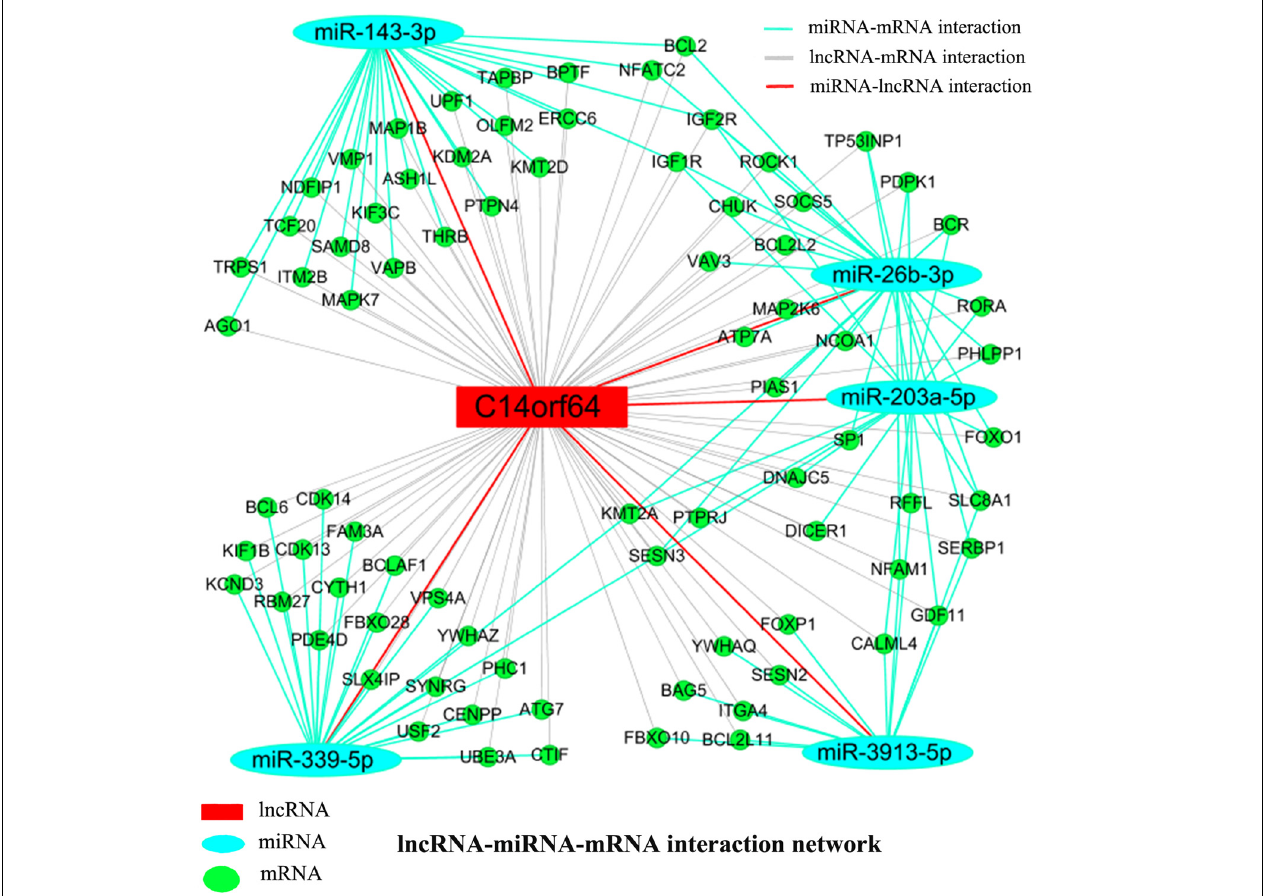
FIGURE 6 | LncRNA-miRNA-mRNA network. A ceRNA network was constructed corresponding to the miRNA, lncRNA and mRNA variations in AIS patients. Light blue oval nodes represent microRNAs, green circular nodes represent mRNAs, and red rectangular nodes represent lncRNAs. Black edges represent the possible relationship between lncRNAs and mRNAs, light blue edges represent the inhibitory effect of miRNAs on mRNAs, and red edges show the relationship between miRNAs and